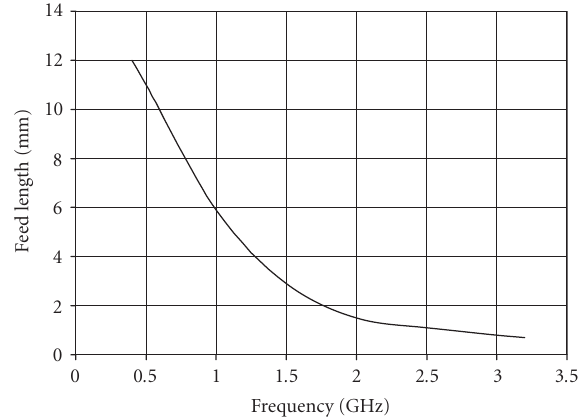
Figure 2: Variation of feed length p with lower band-edge frequency f L for PMAs shown in Figure 1(a).